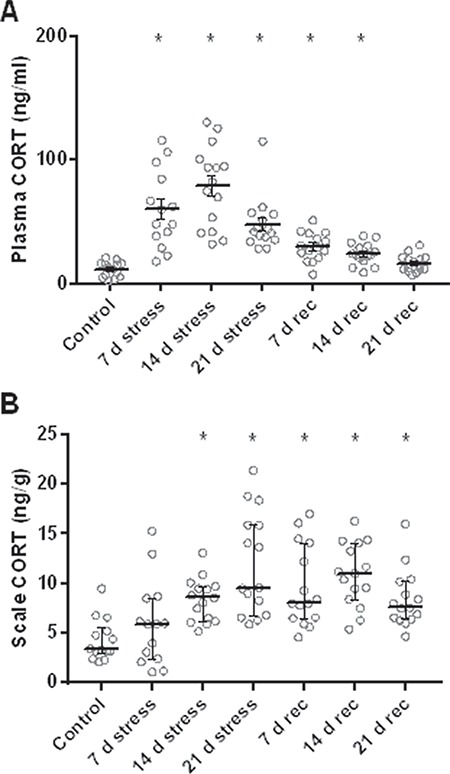
Effects of 21 days of unpredictable chronic daily stressors and 21 days of recovery from such stressors on plasma cortisol (CORT) and scale cortisol content. (A) Cortisol levels in plasma. (B) Cortisol levels in scales. Stressed fish were exposed daily to the stressors shown in Figure 5 in a pseudorandomized sequence for up to 21 days. Fish in recovery groups (rec) were exposed to 21 days of stressors before 1–3 weeks of recovery from stress. Significantly increased levels compared to an unstressed control group are indicated by asterisks. Sample size is 14 in control and 7-day groups and 15 in all other groups. Data are mean ± SEM in A and median and interquartile range in B